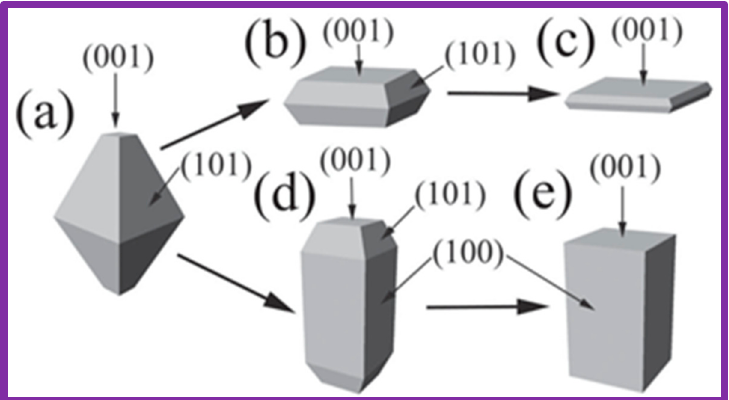
Figure 8. Schematic drawings of anatase shapes: ( a ) slightly truncated tetragonal bipyramid with dominant {101} facets (an equilibrium crystal shape); ( b ) truncated tetragonal bipyramid with a large percentage of top {001} facets; ( c ) square sheet with dominant {001} facets; ( d ) elongated truncated tetragonal bipyramid with a large percentage of lateral {100} facets; ( e ) tetragonal cuboid enclosed by {100} and {001} facets [37]. Reprinted with permission from ref. [37].